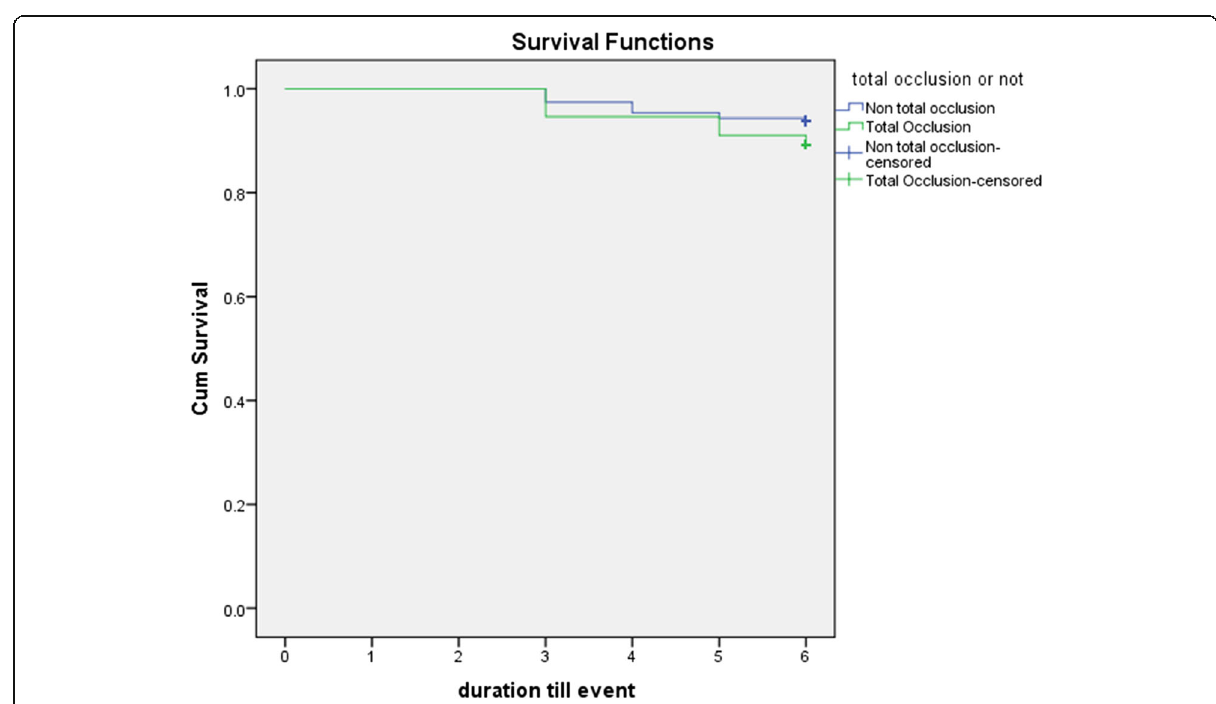
Fig. 1 Kaplan-Meier estimates of MACCE between the two groups at 6